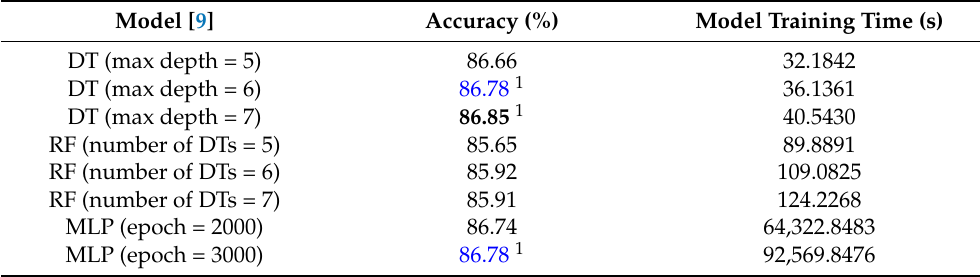
Table 4. Performance results of the ML models for TT_H decisions.